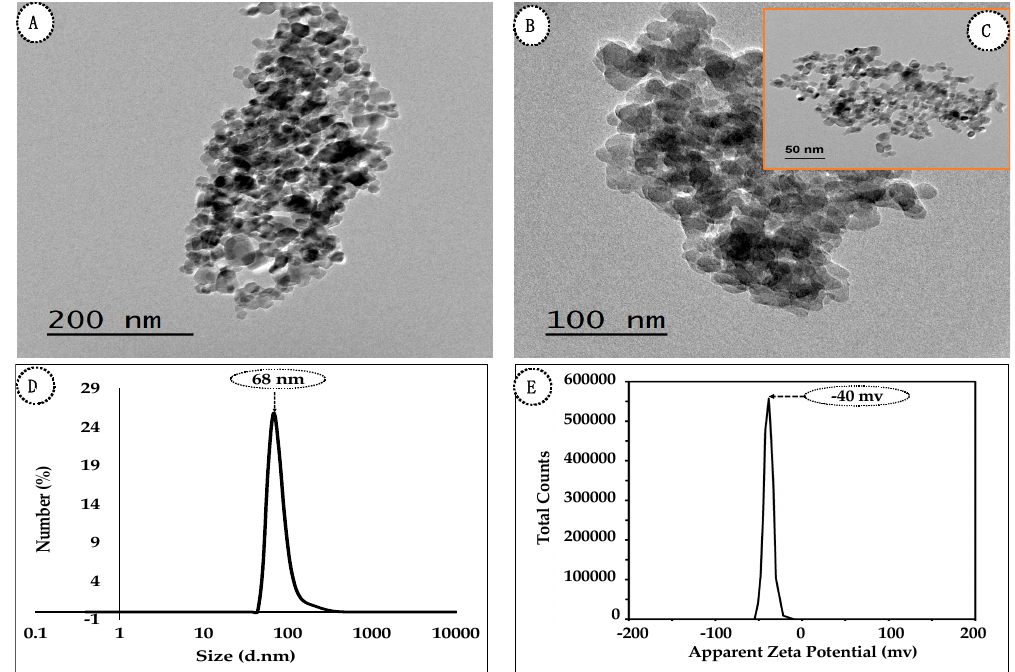
Figure 1. ( A , B , C ) TEM at low and high magnifications, ( D ) average particle size and ( E ) zeta potential of SiO 2 -NPs.